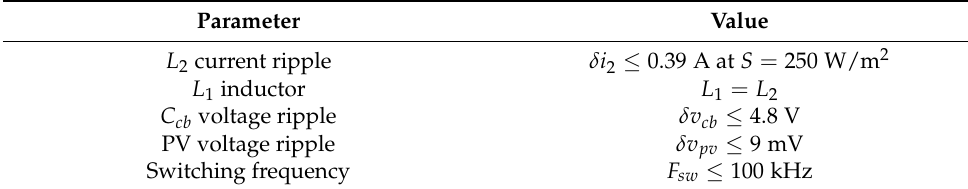
Table 2. Design characteristics for the NEC boost